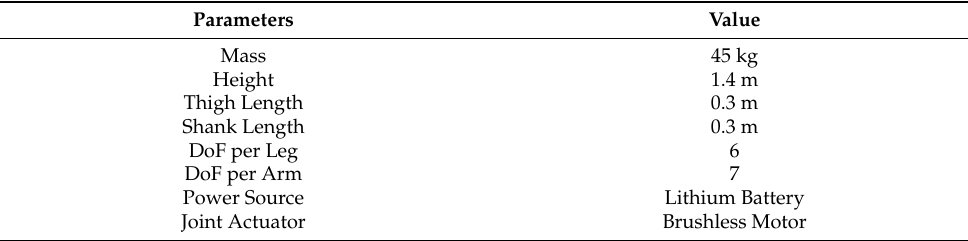
Table A1. Wukong-IV Hardware